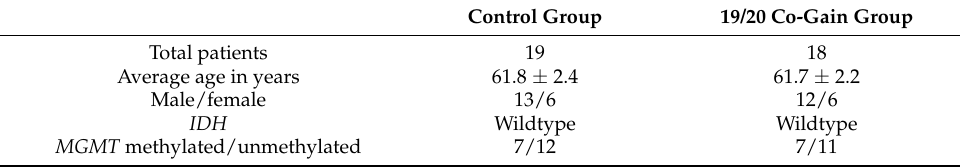
Table 1. Patient characteristics.